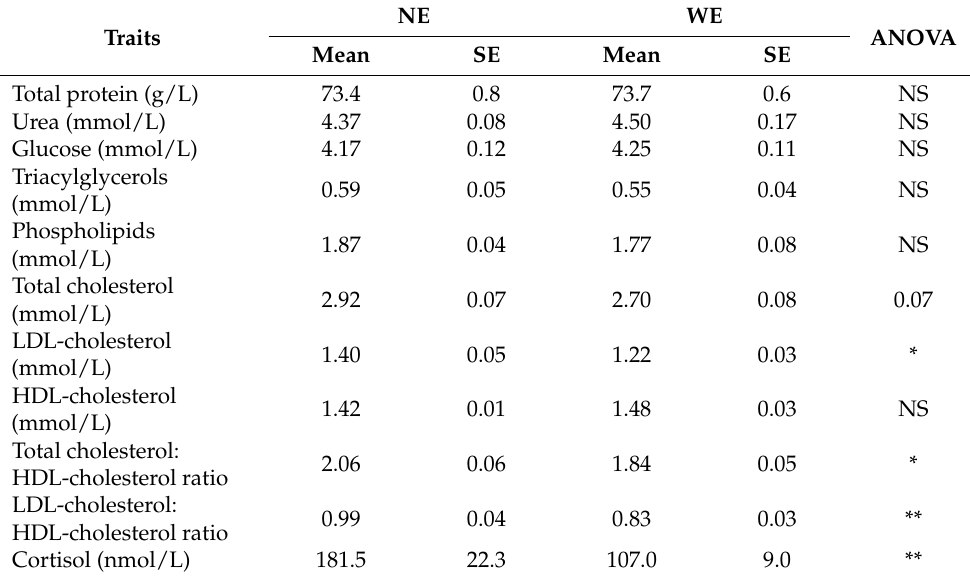
Table 4. Plasma parameters from Alentejano pigs kept on individual pens without exercise area (NE, n = 9) or outdoors with exercise area (WE, n = 9) at week 18 of the trial. NE WE Traits ANOVA Mean SE Mean Total protein (g/L)